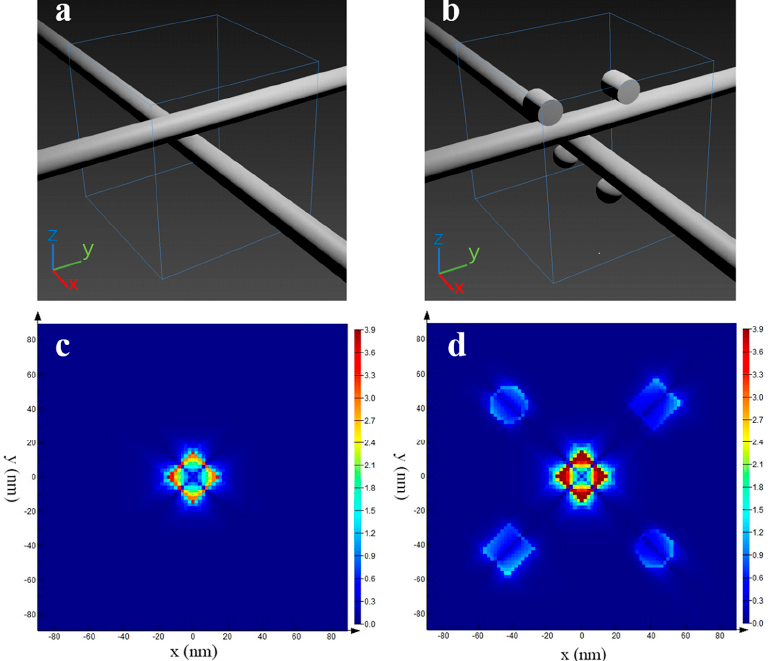
Figure 8. Three-dimensional (3D) images of theoretical models of silver nanowire membrane ( a ) and CV-treated silver nanowire membrane ( b ). DDA simulations of the electric field on untreated ( c ) and treated ( d ) silver nanowire membrane.